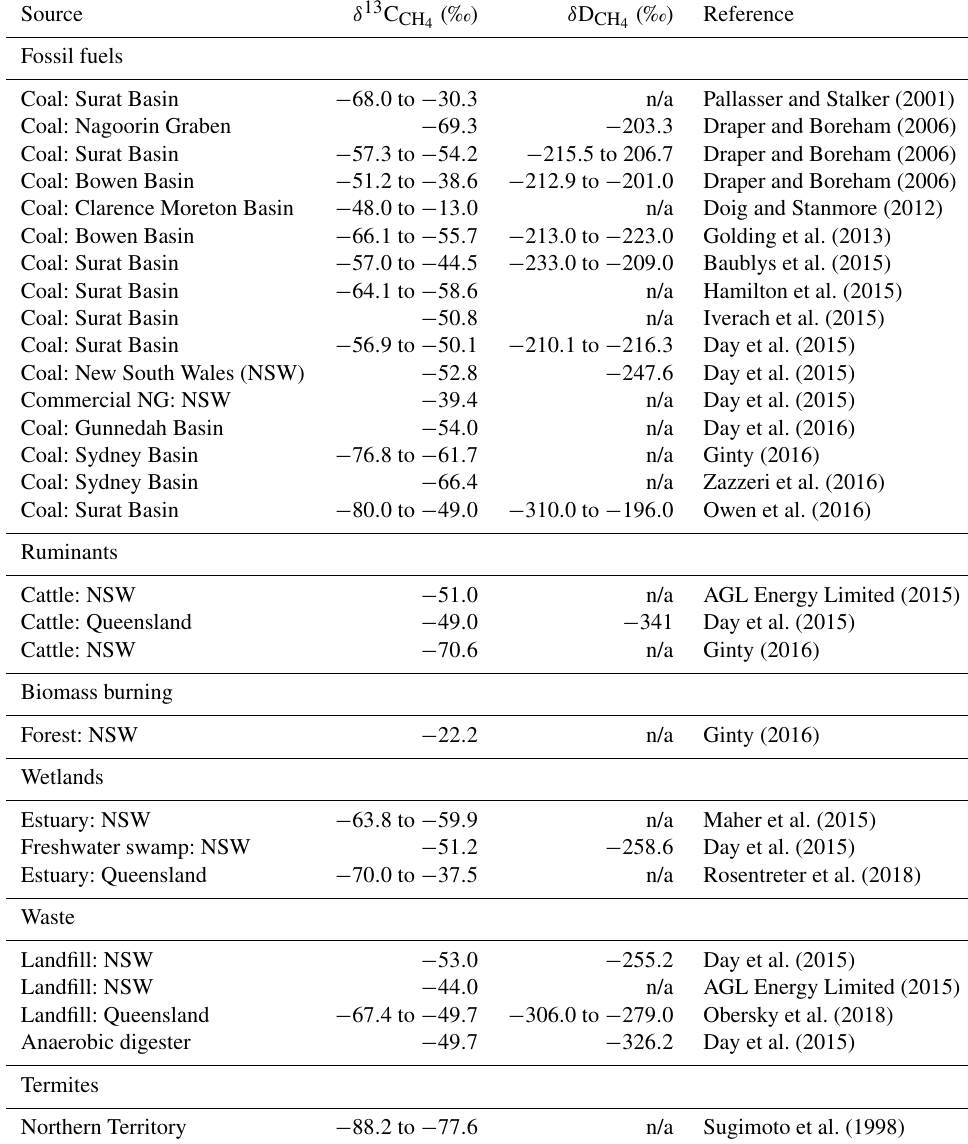
Table 1. Summary of isotopic characterization of CH 4 sources in Australia from the literature (in addition to Sherwood et al., 2017). n/a: not